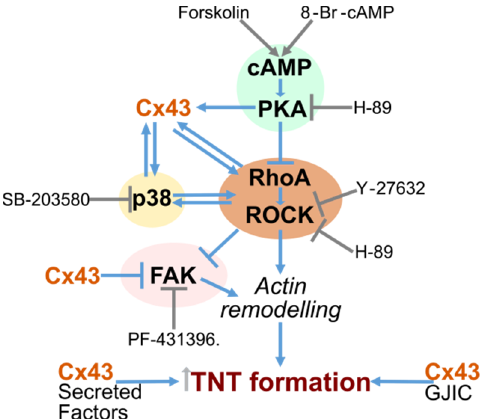
Figure 7. Cell signaling pathways and links to Cx43 and TNT formation.